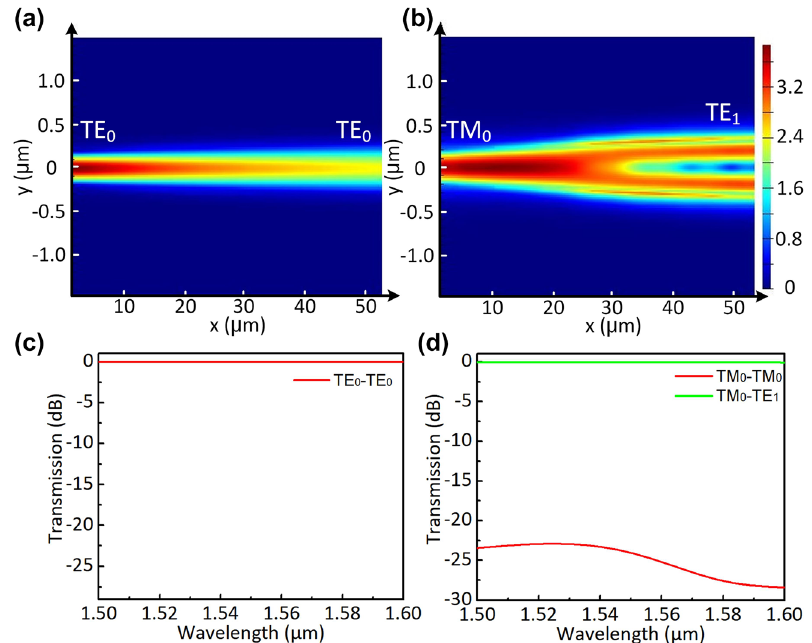
Figure 3: Simulated light propagation in the designedPDMCforthelaunchedTE 0 (a)and TM 0 (b) modes with the FDTD method; and calculated transmission spectra in the designedPDMCforthelaunchedTE 0 (c)and TM 0 (d)